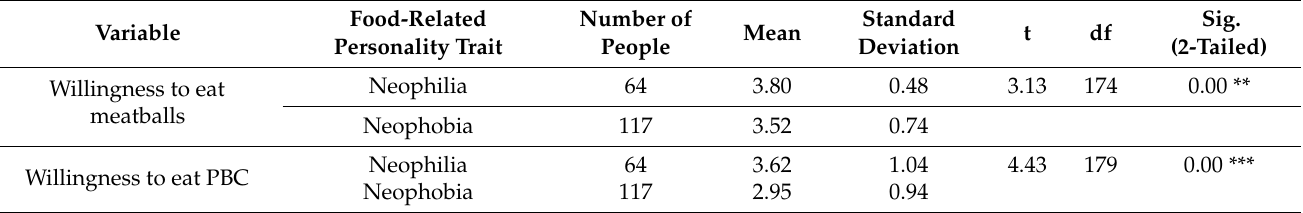
Table 4. Effect of food-related personality traits on foreigners’ willingness to eat meatballs ( n =